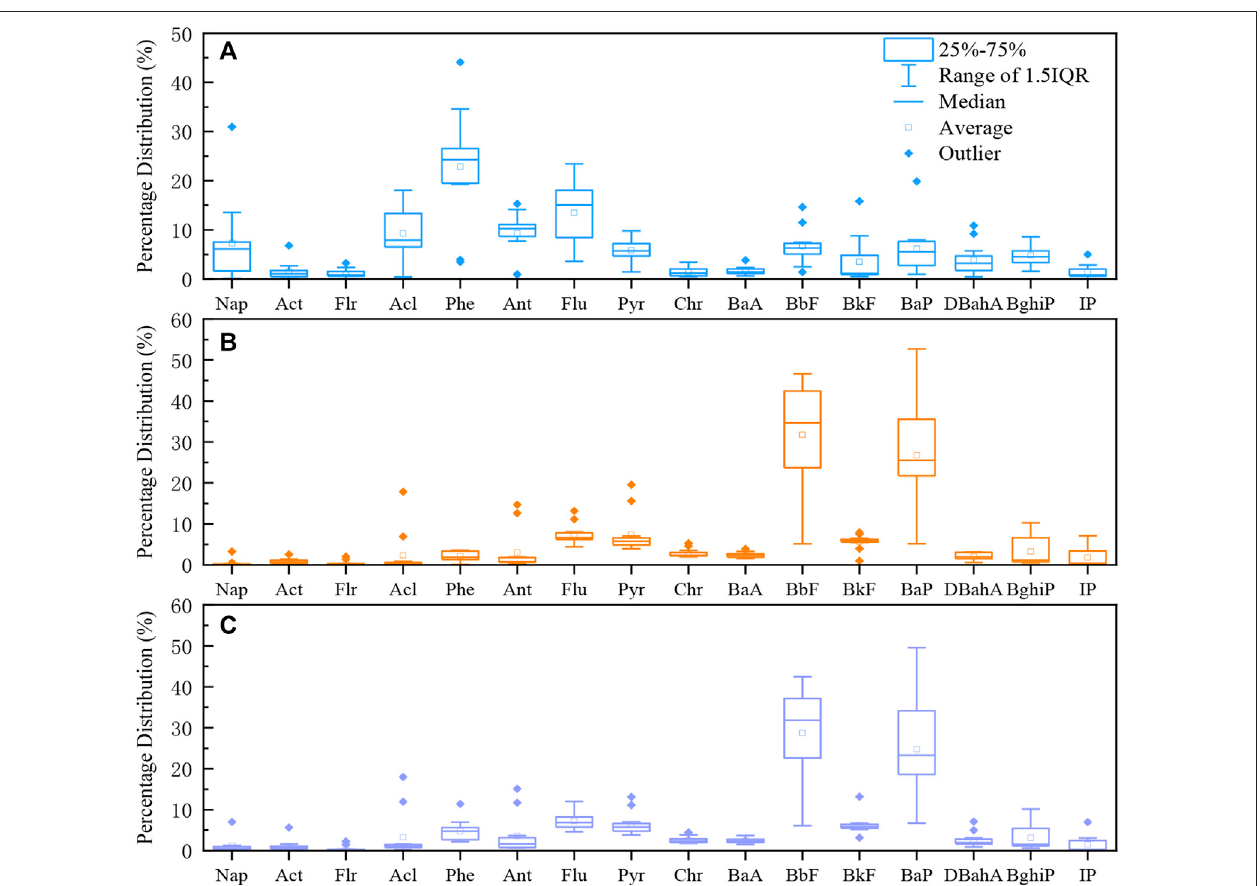
FIGURE 5 | Percentages of PAH isomers for all the samples. (A) gas phase samples; (B) particulate phase samples; (C) total emission samples.